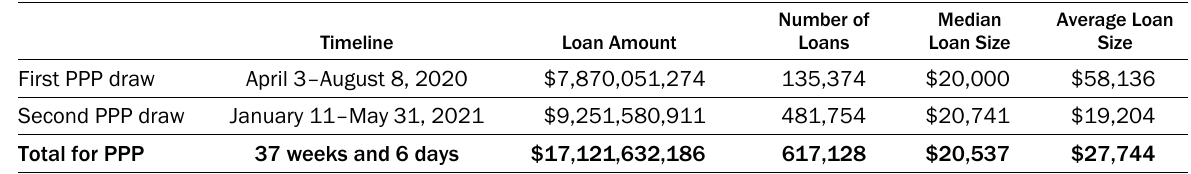
Table 1. Paycheck Protection Program (PPP) Loans to Agriculture